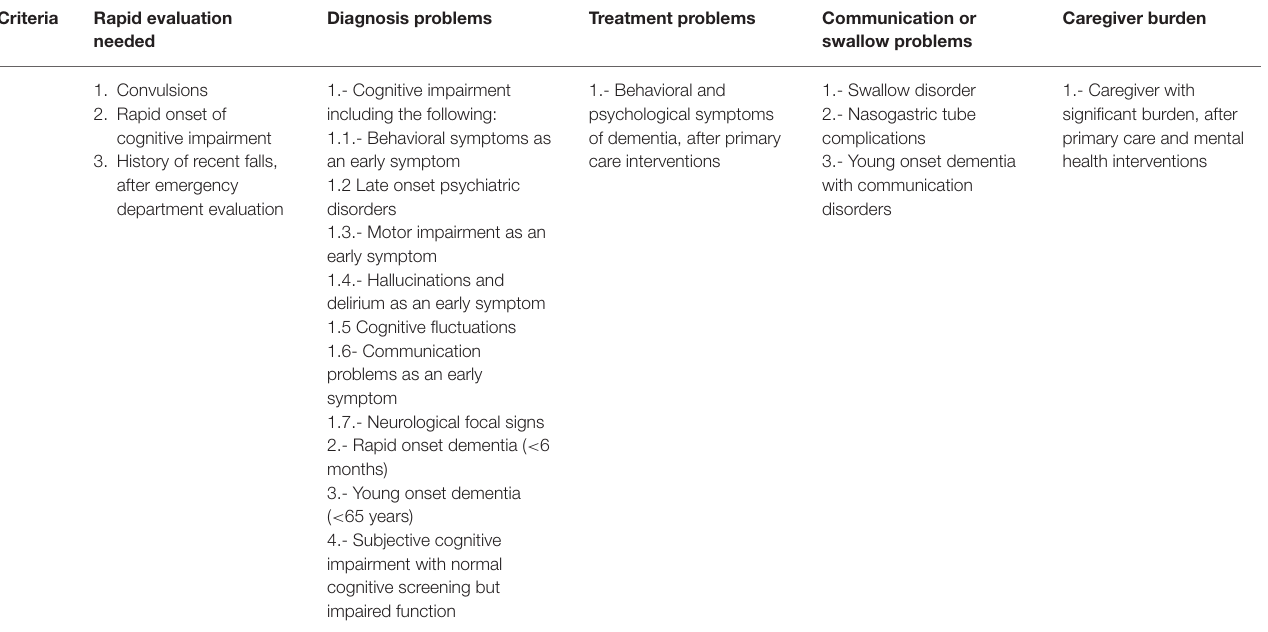
TABLE 1 | Criteria for referral to specialist care according to the Plan.